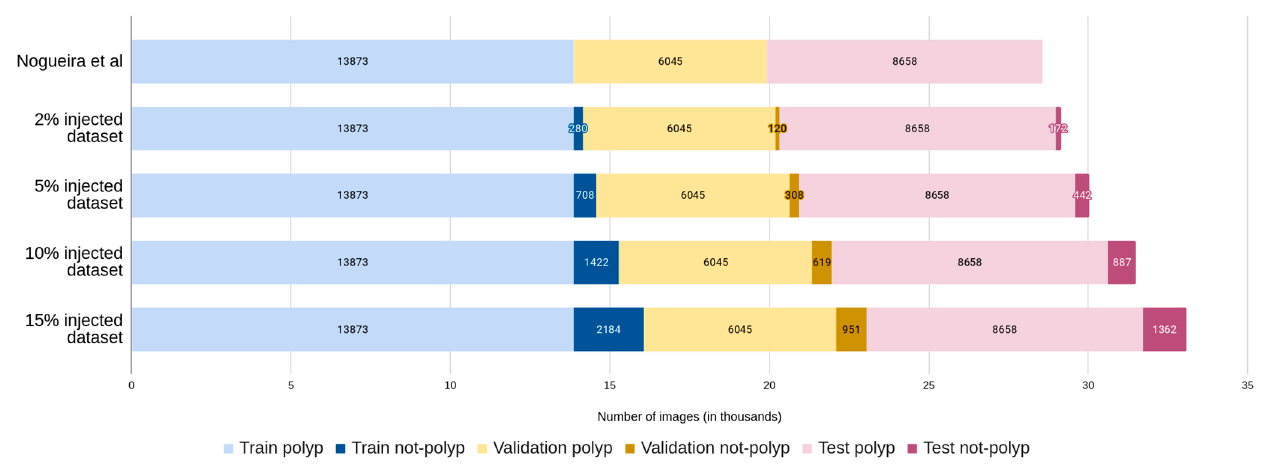
Figure 1. Not-polyp datasets created from the original polyp images dataset [11].